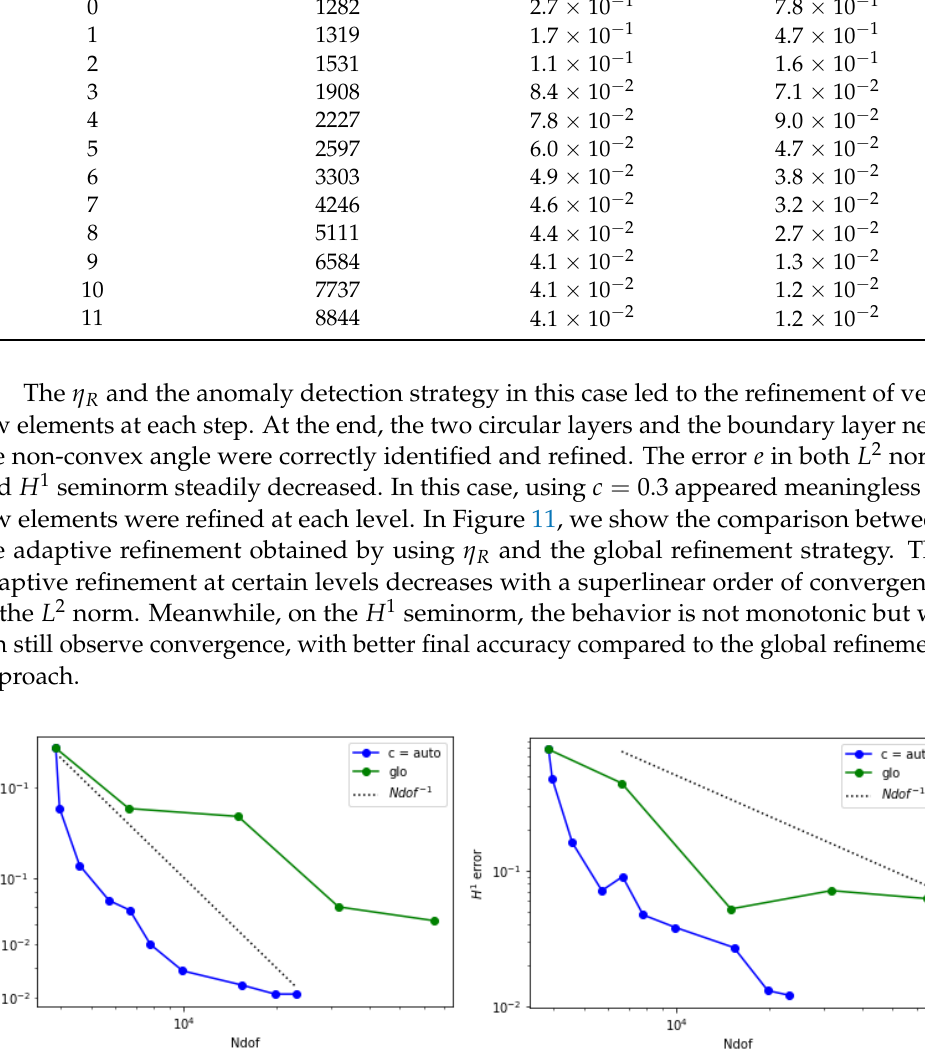
Figure 11. Error behavior for example 2 when η R is adopted. ( Left ) The estimated L 2 norm of the error is displayed. ( Right ) The estimated H 1 seminorm is shown.